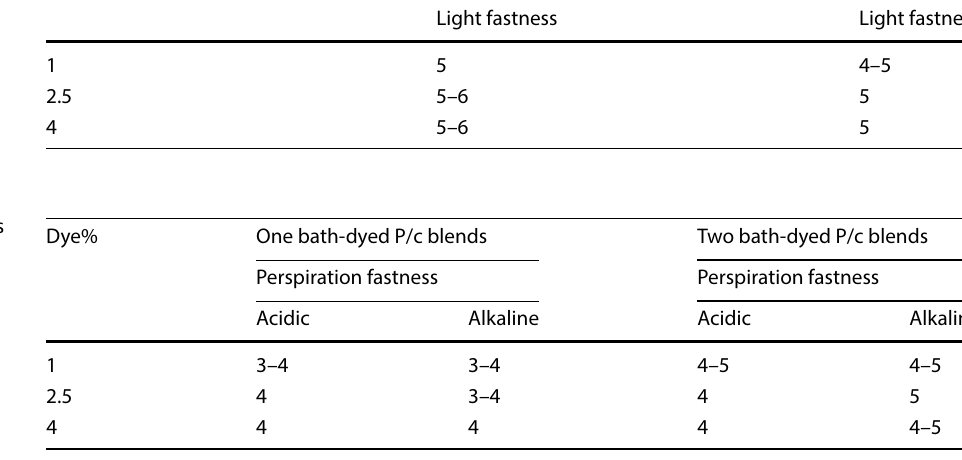
Table 8 Light fastness properties of modified P/c blend and conventional